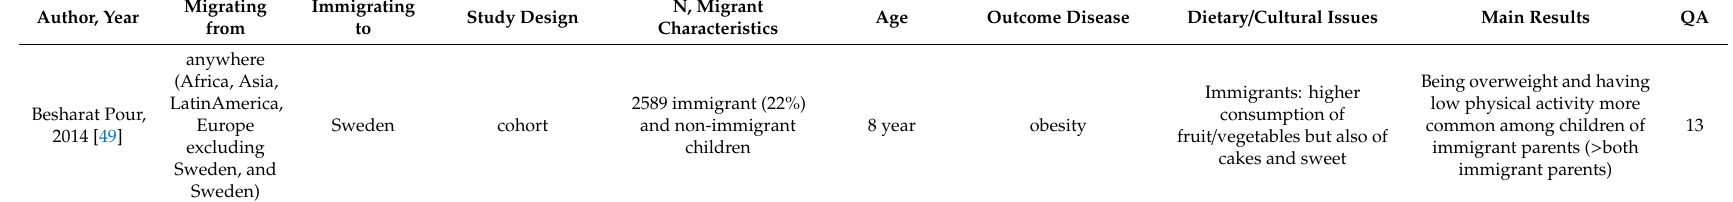
Table 4. Characteristics and main results of the included studies.